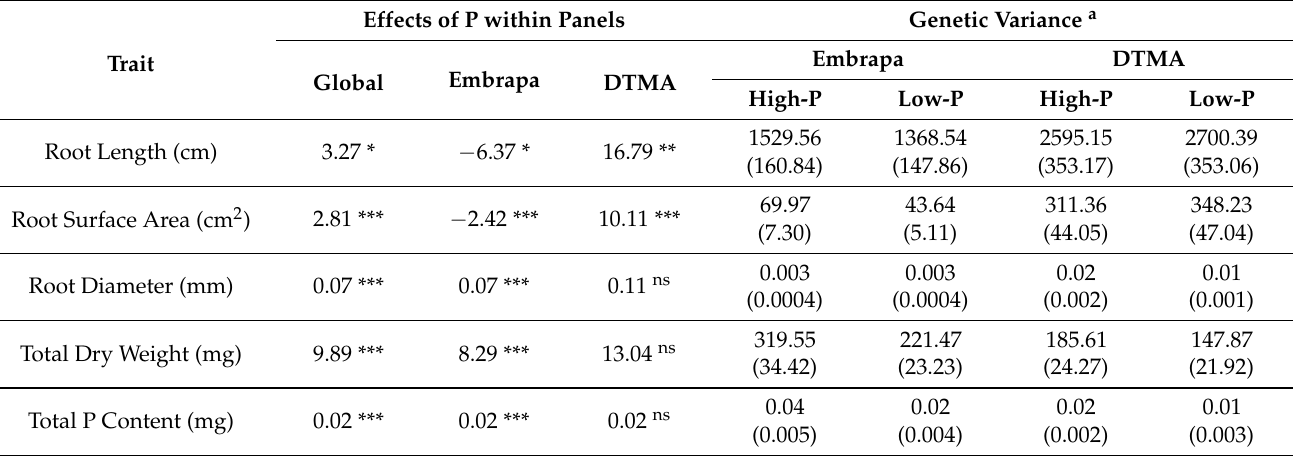
Table 3. Effects of contrasts between low- and high-P levels and the genetic variance for each trait within global, Embrapa and DTMA panels. The positive sign of the effect indicates that the average under high-P conditions was superior to low-P conditions, whereas the negative sign indicates a higher average under low-P conditions compared to high-P conditions. The Embrapa panel was composed of 365 lines and the DTMA panel, of 196 lines, in a total of 561 maize lines.